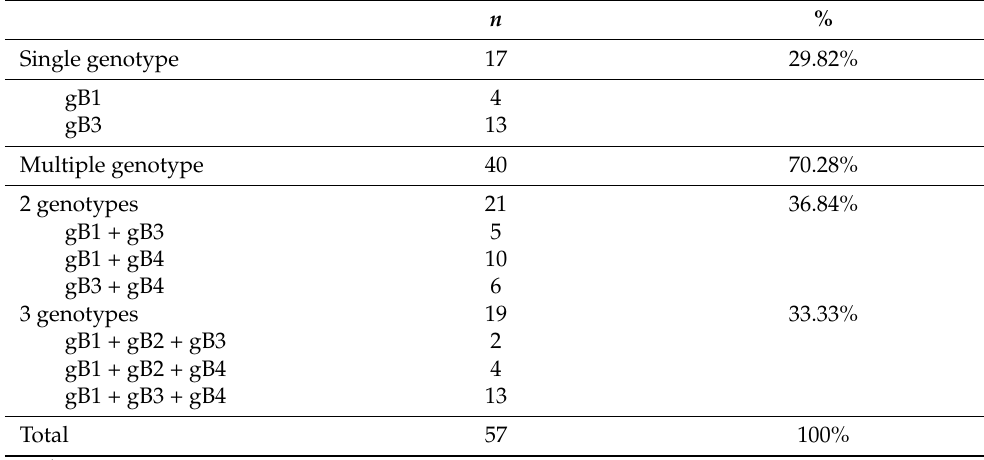
Table 2. The distribution of cytomegalovirus glycoprotein B genotype in the patients with anterior segment